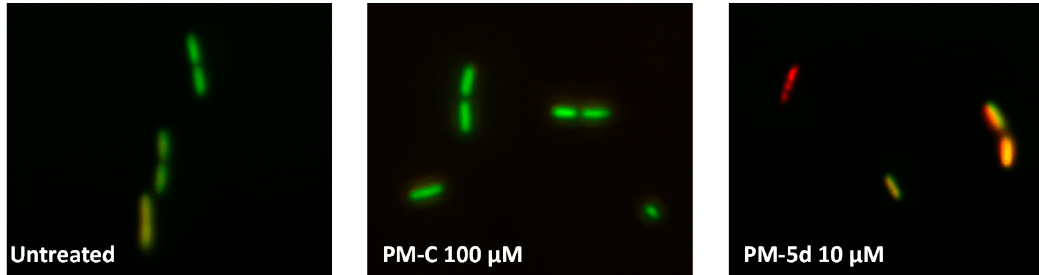
Figure 3. Fluorescence micrographs of P. aeruginosa cells treated for 24 h with 100 µ M of PM- C or 10 µ M of PM 5d after AO / EB double staining. Control represents untreated cells. Green (AO) are viable cells, red (EB) dead cells, and orange vital cells with damaged membranes.